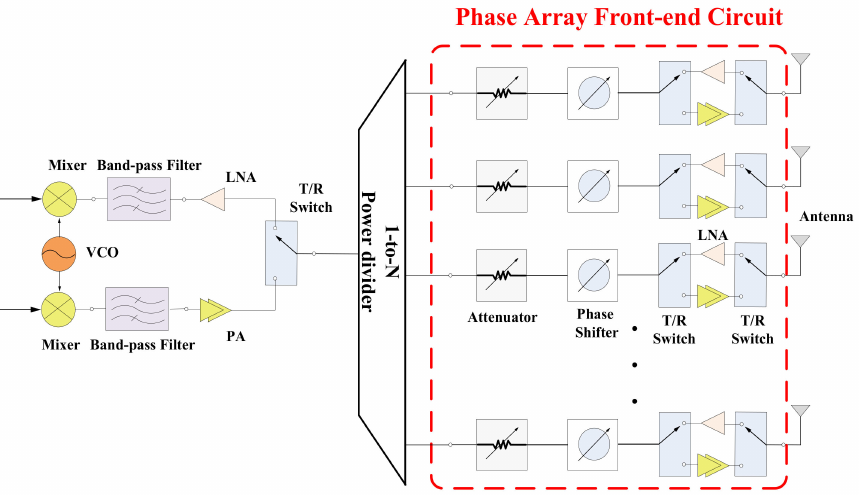
Figure 1. Schematic of radio frequency (RF)